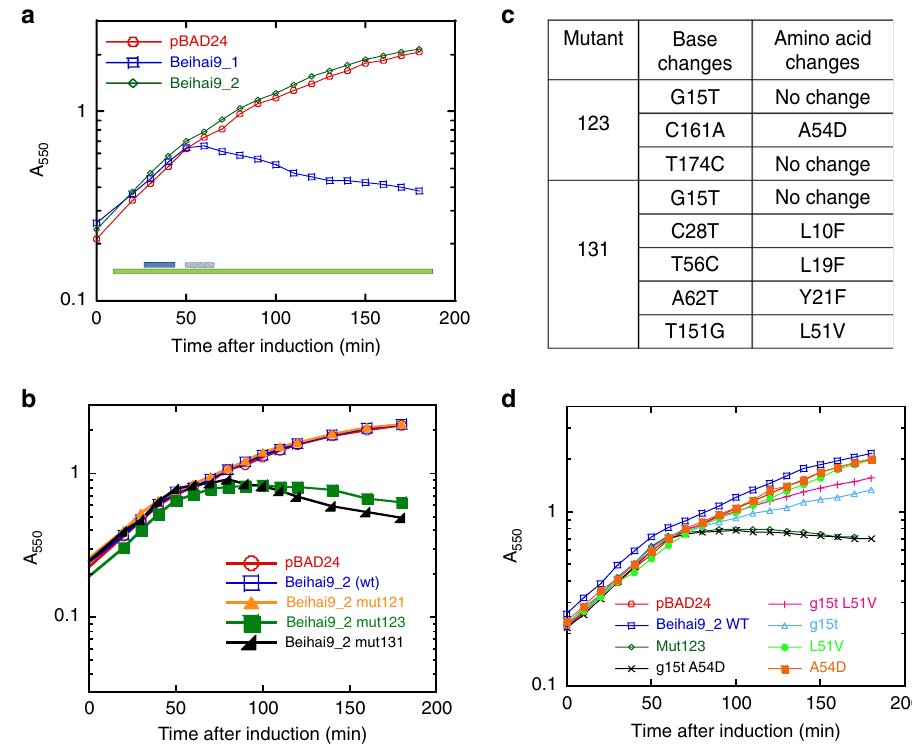
Fig. 4 ssRNA phage with two functional lysis genes. a Lysis pro fi les of two sgl candidates (Beihai9_1 and Beihai9_2); pBAD24 (red open circle), Beihai9_1 (blue open squares), Beihai9_2 (green open diamond).The genomic context of sgl s is shown relative to the rep gene (green bar) with the functional candidate (Beihai9_1) shown as dark blue and the non-functional candidate as light blue. b The lysis pro fi les of Beihai9_2 gain-of-function mutants 123 and 131; pBAD24 (red open circle), Beihai9_2 (blue open square), Beihai9_2 mut121 (light orange- fi lled triangle), Beihai9_2 mut123 (green- fi lled square), Beihai9_2 mut131 (black- fi lled right triangle). c Table summarizing the base and amino acid changes of the mutants in b . d The lysis pro fi les of Beihai9_2 of single and double mutant constructs; pBAD24 (red open circle), Beihai9_2 (blue open squares), Beihai9_2 mut123 (green open diamond), Beihai9_2 double mutant g15t A54D (black cross), Beihai9_2 double mutant g15t L51V (pink plus), Beihai9_2 g15t (light blue open triangle), Beihai9_2 L51V (light green- fi lled circle), and Beihai9_2 A54D (orange- fi lled squares). The lysis pro fi les shown here are representative of three biological